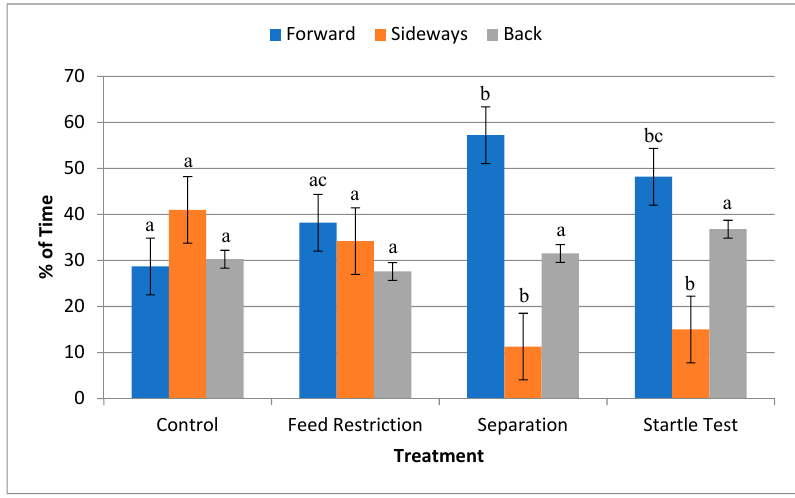
Figure 3 . Percentage of time that horses’ ( n = 33) ears were forward, sideways or back (±SD) over a 3 min observation period during feed restriction, separation from conspecifics, a startle test or control. a,b,c differ across treatments p < 0.0001.